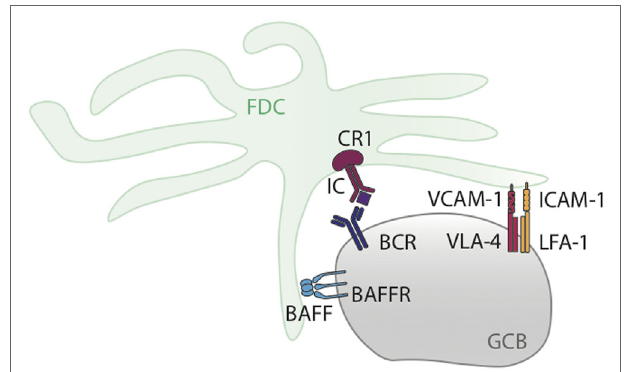
FiGURe 1 | Graphical representation of GC B cell–follicular dendritic cell (FDC) interaction in the germinal center (GC). The diagram shows key molecules involved in the interactions between GC B cells and FDCs happening during GC responses and discussed in Section “B Cell–Follicular Dendritic Cell (FDC)